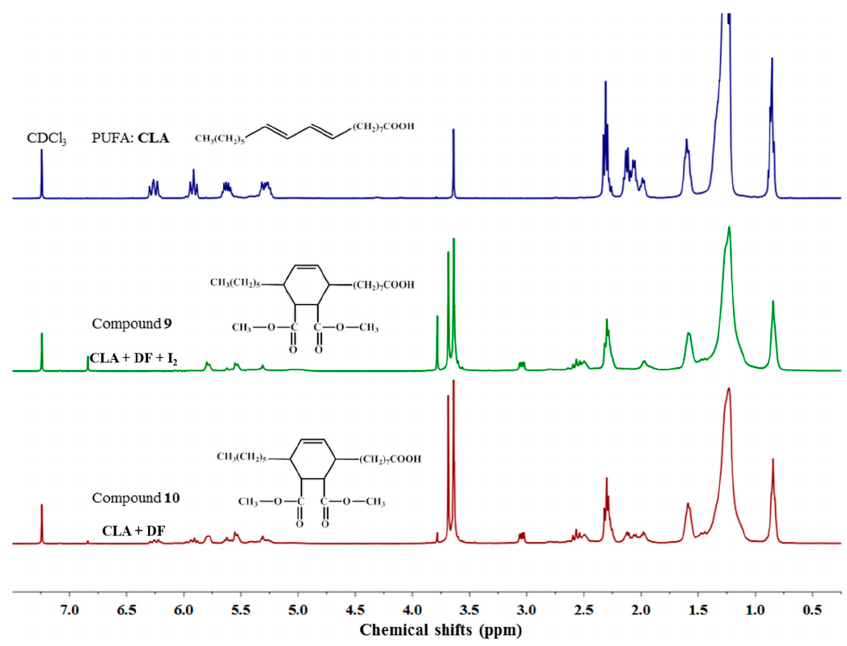
Figure 3. 1 H-NMR spectra of conjugated linoleic acid (CLA) and the reaction compounds with dienophiles in chloroform-d under di ff erent catalyst conditions: compound 9 , reaction products of CLA and DF with iodine catalysis; compound 10 , reaction products of CLA and DF without iodine